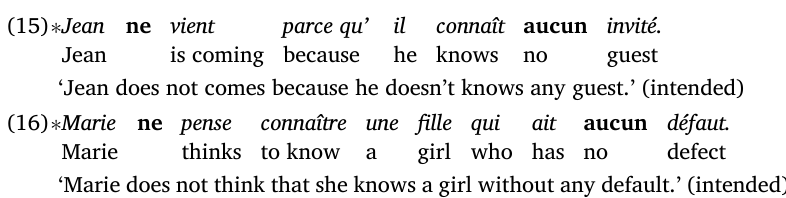
Frigram: a French Interaction